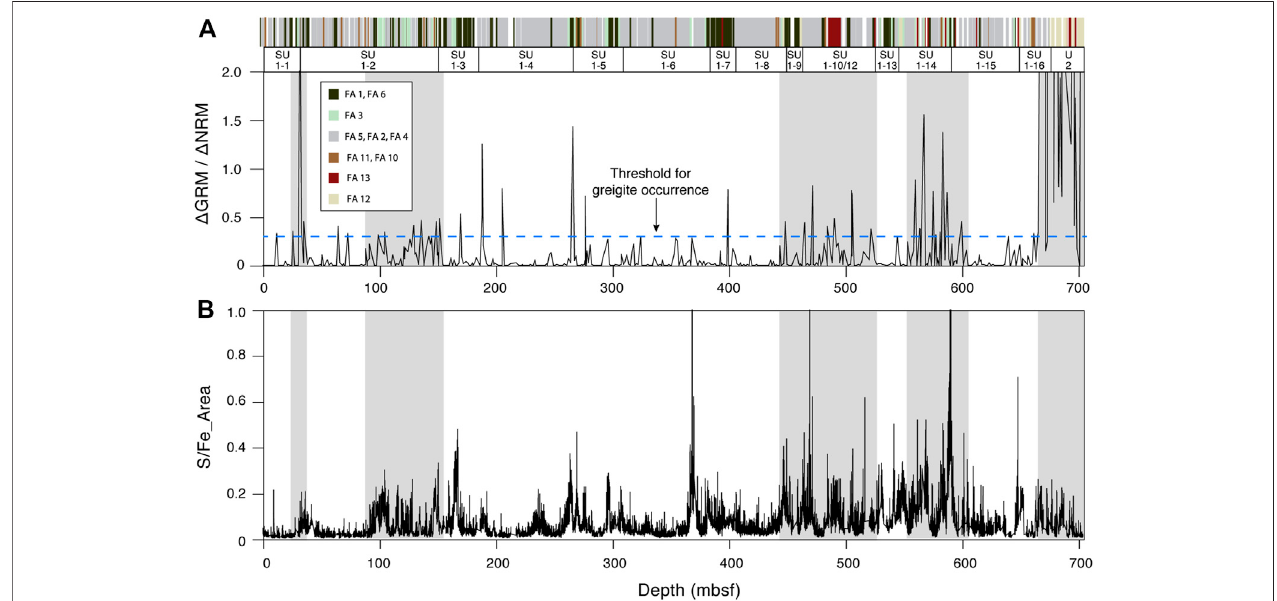
FIGURE2| Greigiteconcentrationproxies. (A) Δ GRM/ Δ NRMratiocalculatedusingapproachbyFuetal.(2008).Theverticalaxishasbeenexpandedtoappreciate smaller variations in greigite concentration (data falling outside the plot have values up to 31.75). Colored log above the plot is the distribution of the facies associations (FA)identi fi edatHoleM0079A(seeMcNeilletal.,2019bforFAkeys).Subunit(SU)andunit(U)nameaccordingtoMcNeilletal.,2019bareindicated,whereoddnumbers arethemarine/interglacialintervals, and evennumber aretheisolated/glacialintervals. Gray shaded areasaretheintervals showinghigher concentrationofgreigite (i.e., Δ GRM/ Δ NRM > 0.3); (B) Sulfur/Iron ratio (S/Fe) based on XRF data from Hole M0079A (McNeill et al.,